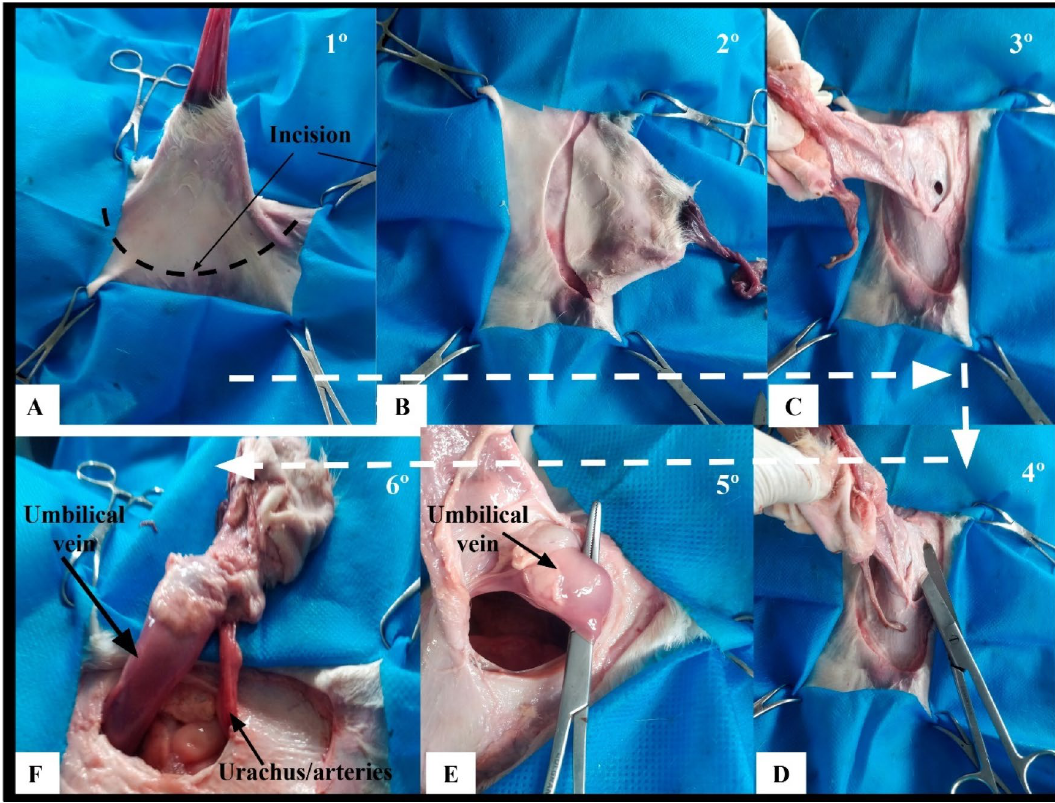
Figure 2. Steps for intra-abdominal access to the umbilical vein and urachus in